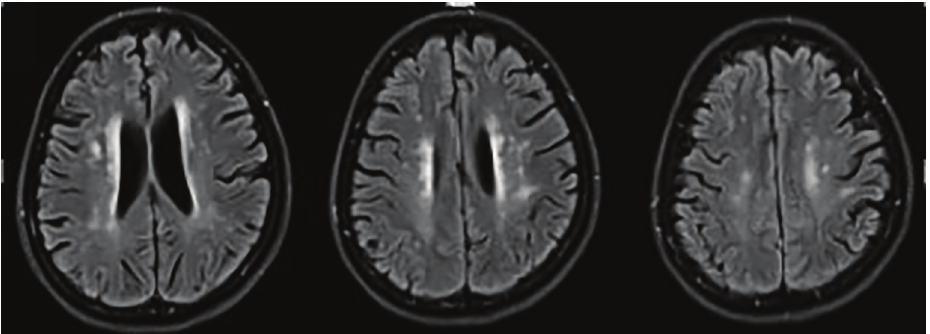
Figure 4. Head MRI and T2WI images of III9 (currently no clinical symptoms). Image shows bilateral lateral ventricles, bilateral semi-oval center with multiple patchy abnormal signal, and the white matter of the bilateral lateral ventricle slightly